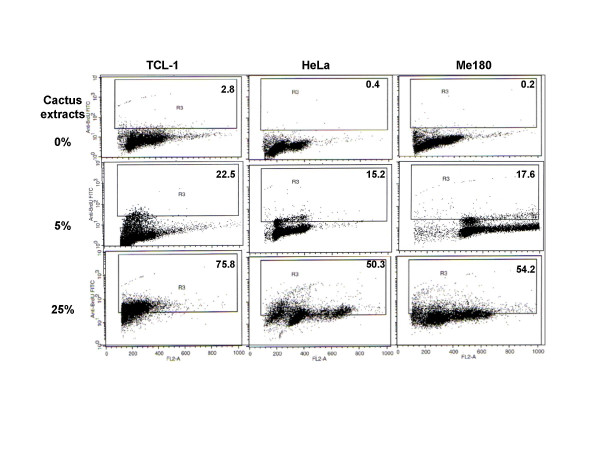
Apoptosis induction analyzed by TUNEL assay in cervical cells. Cells were treated with 5% and 25% cactus pear solution for 2 days. Cells were harvested and incubated with TdT in the presence of biotin-labeled BrdU and analyzed by flow cytometry. The percentage of apoptotic cells is represented by dark dots (fluorescence of individual cells) above the line in R3 region (R3 is the computer software analysis apoptosis program).